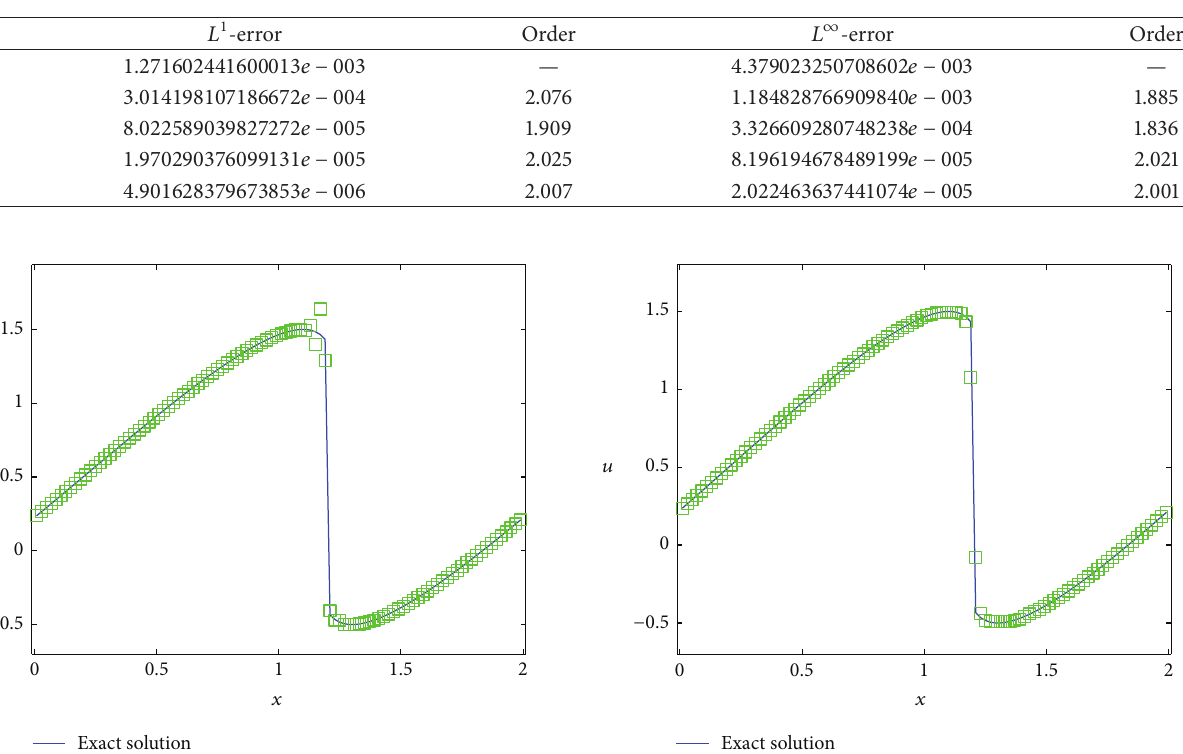
Table 2: Initial value problem (65) and 𝐿 1 and 𝐿 ∞ norms of the errors.